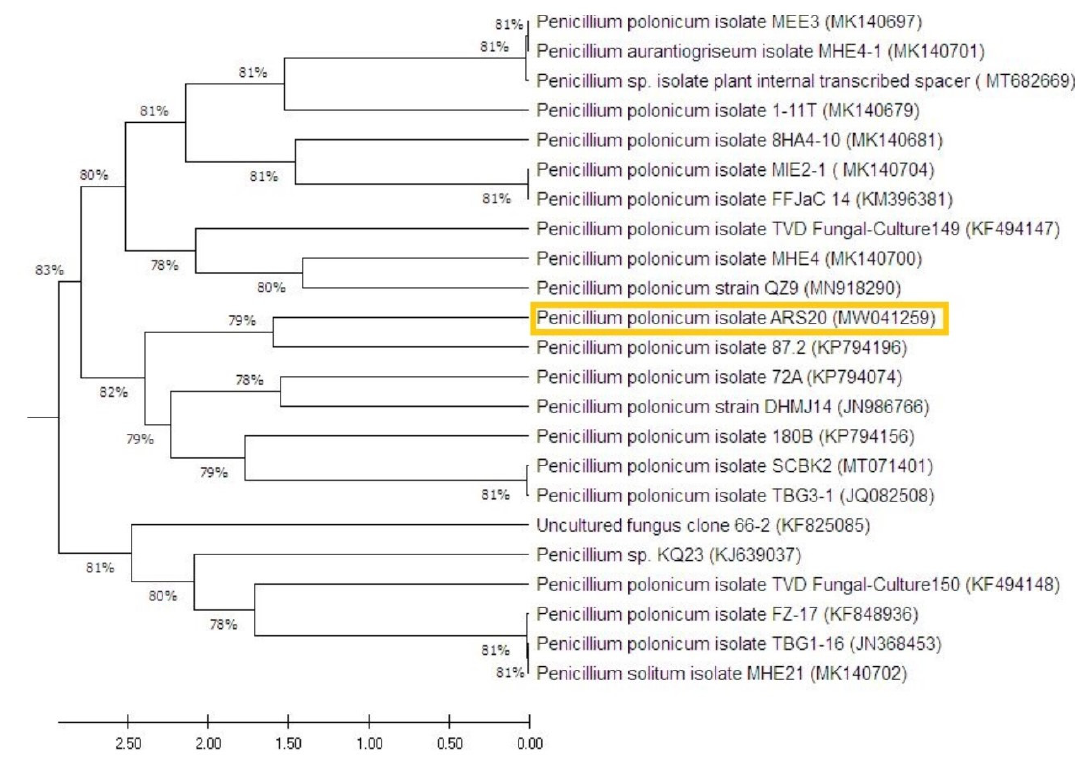
Figure 6. Molecular phylogenetic tree of the partial sequence of the internal transcribed spacer, showing the position (highlighted with the yellow rectangle) of Pencillium polonicum ARS20 (MW041259) with respect to the closely related sequences obtained from GenBank.